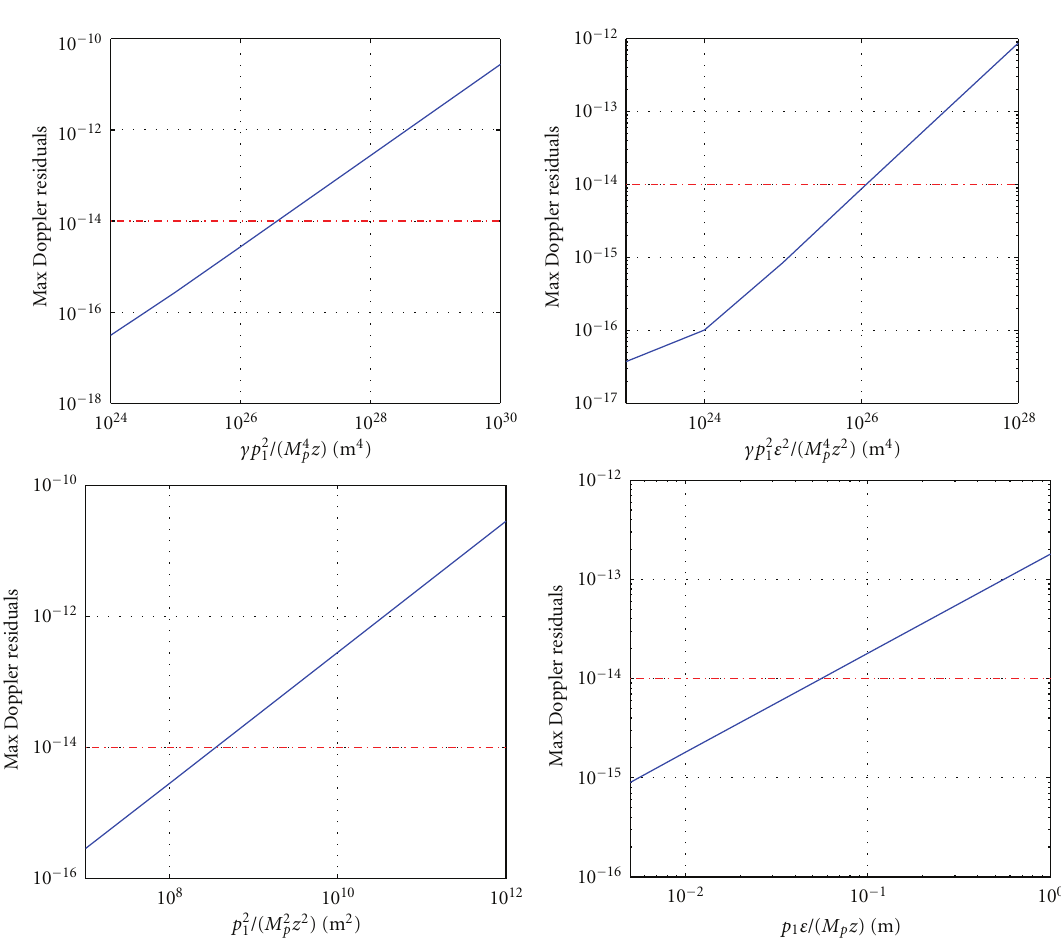
Figure 12: Representation of the maximal Doppler residuals signal due to John + George modification of gravity parametrized by the four parameters in the metric (23)–(24b) for the Cassini mission between Jupiter and Saturn. The red (dashed) lines represent the assumed Cassini